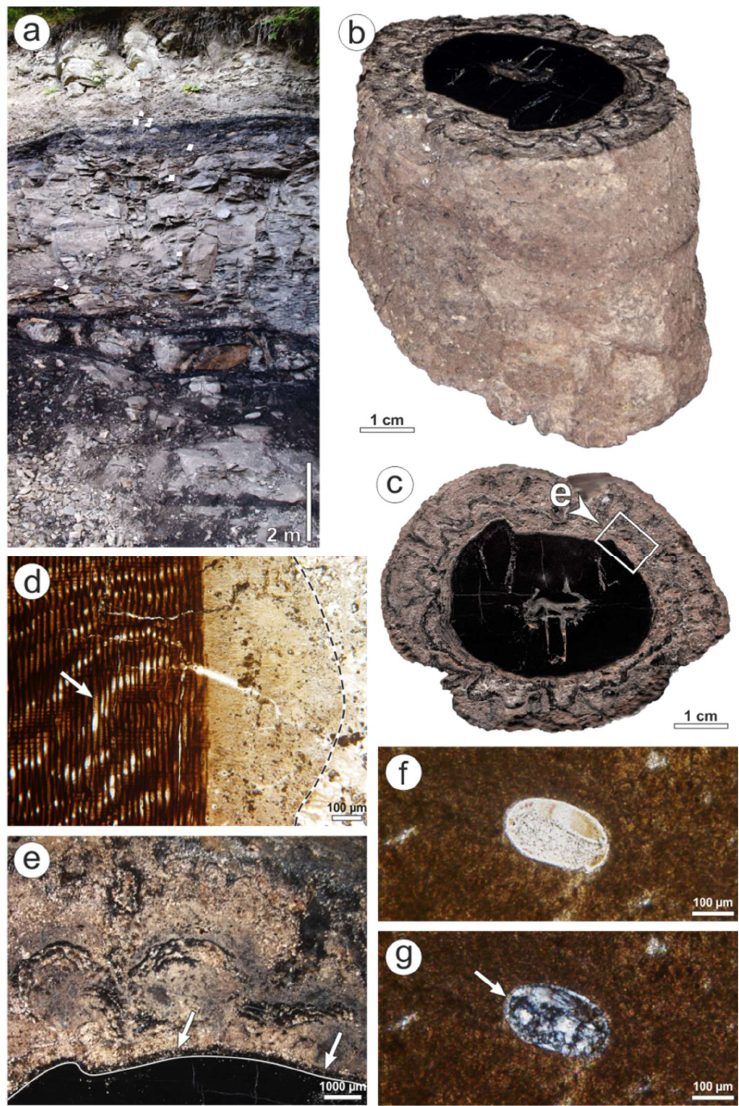
Figure 12. Features of 1977/7 and its host rock from Manebach. ( a ) Typical section of the Manebach Fm. showing a vertical succession of floodplain siltstones (grey), fluvial sandstones (pale yellow) and intercalated coal seams (black). ( b ) Permineralized Agathoxylon -type stem, encrusted completely by a stromatolite; lateral view (1977/7). ( c ) Cross-section of B. Note the uniform thickness of the stromatolitic mantle. ( d ) Interface of stem (left) and silicified stromatolite (right); radial view; PPL image. Exceptional preservation in Manebach is reflected by delicate anatomical features, such as pits in the tracheids (arrow), and microbial filaments in silicified parts of the stromatolite (left of the dotted line). ( e ) Interface of permineralized stem (black) and stromatolite. Whereas calcite prevails in the stromatolite, silicification is limited to single black laminae, and a fringe around the stem (arrows and continuous line). ( f ) Ostracod within the stromatolite; PPL image. ( g ) Same as (f); XPL image. The ostracod is completely filled by quartz, which also replaced calcite in the shell. Residual calcite is indicated by interference colors of higher orders (arrow).